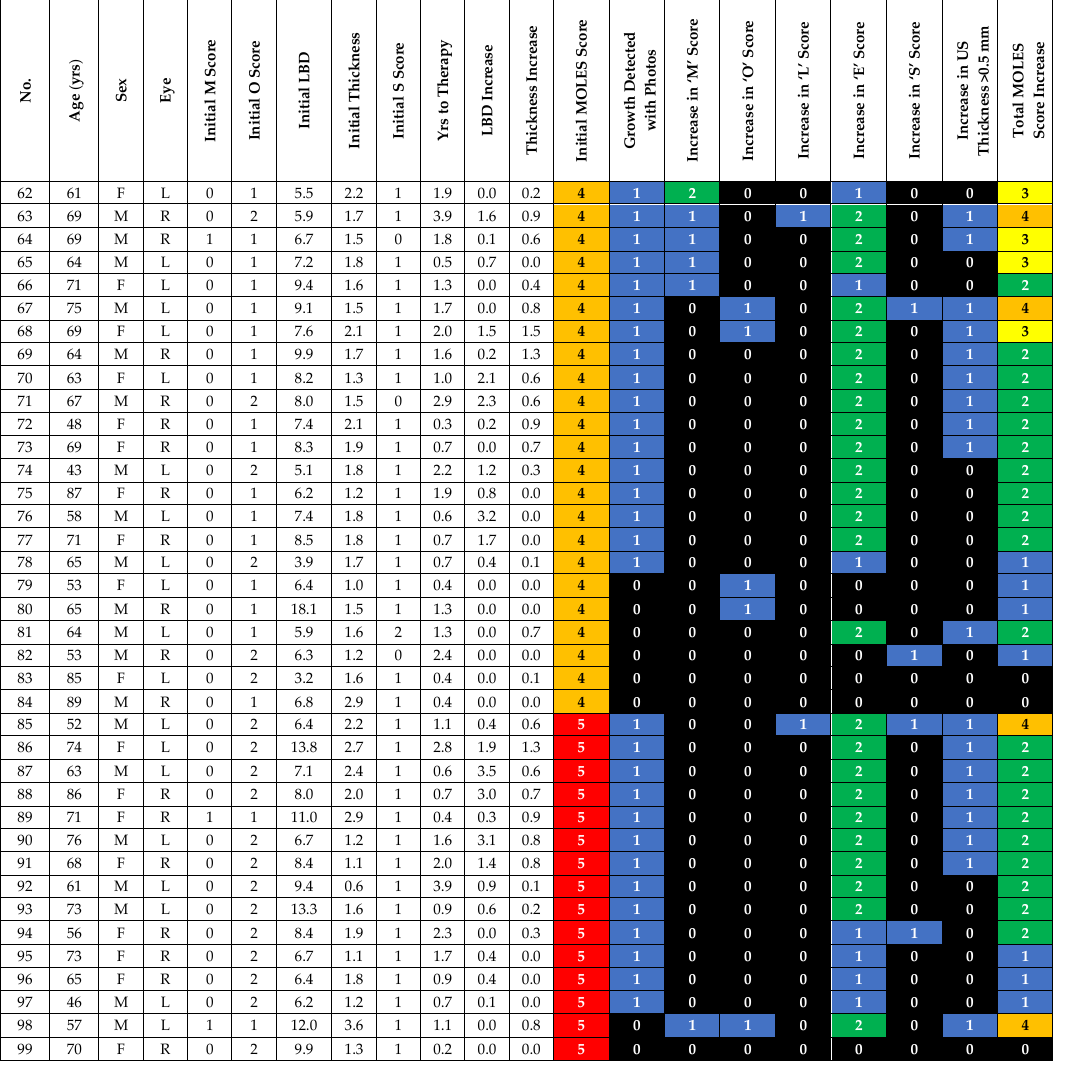
Figure 3. Demographic, baseline and progression details of MOLES 4/5 cases.